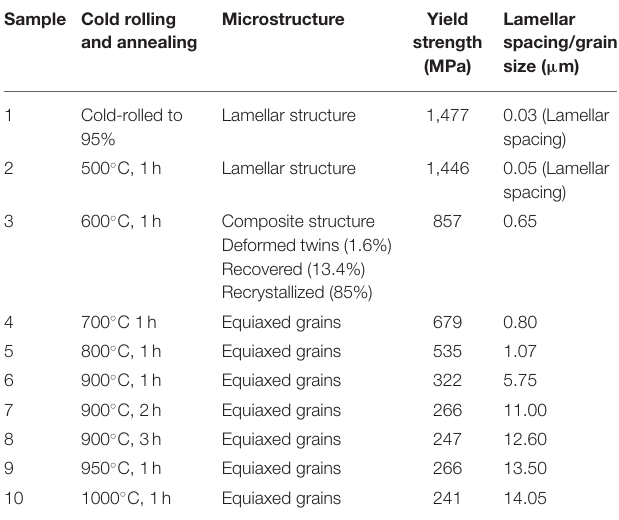
TABLE 2 | Microstructure, structural parameters, and yield strength of the investigated steel cold rolled to 95%, followed by annealing under different conditions.